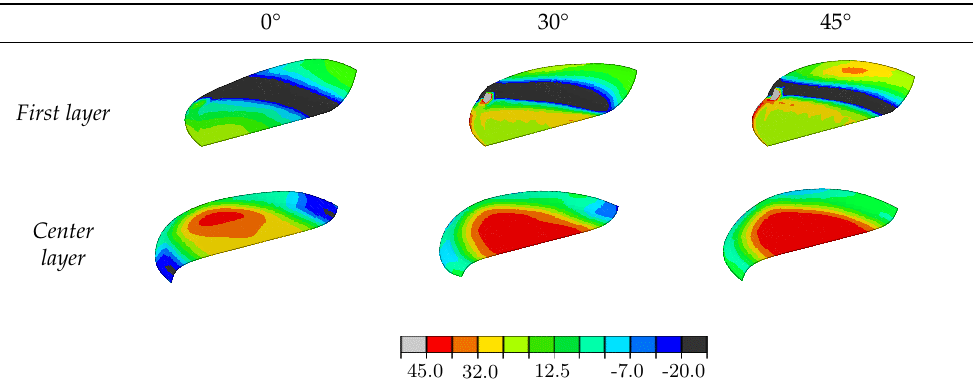
Figure 21. Influence of reinforcement orientation on the axial stress S11 distribution.